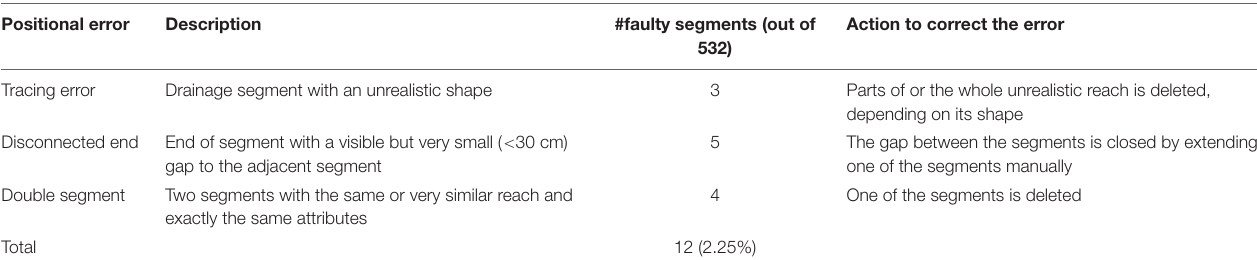
TABLE 4 | Analysis of positional errors.